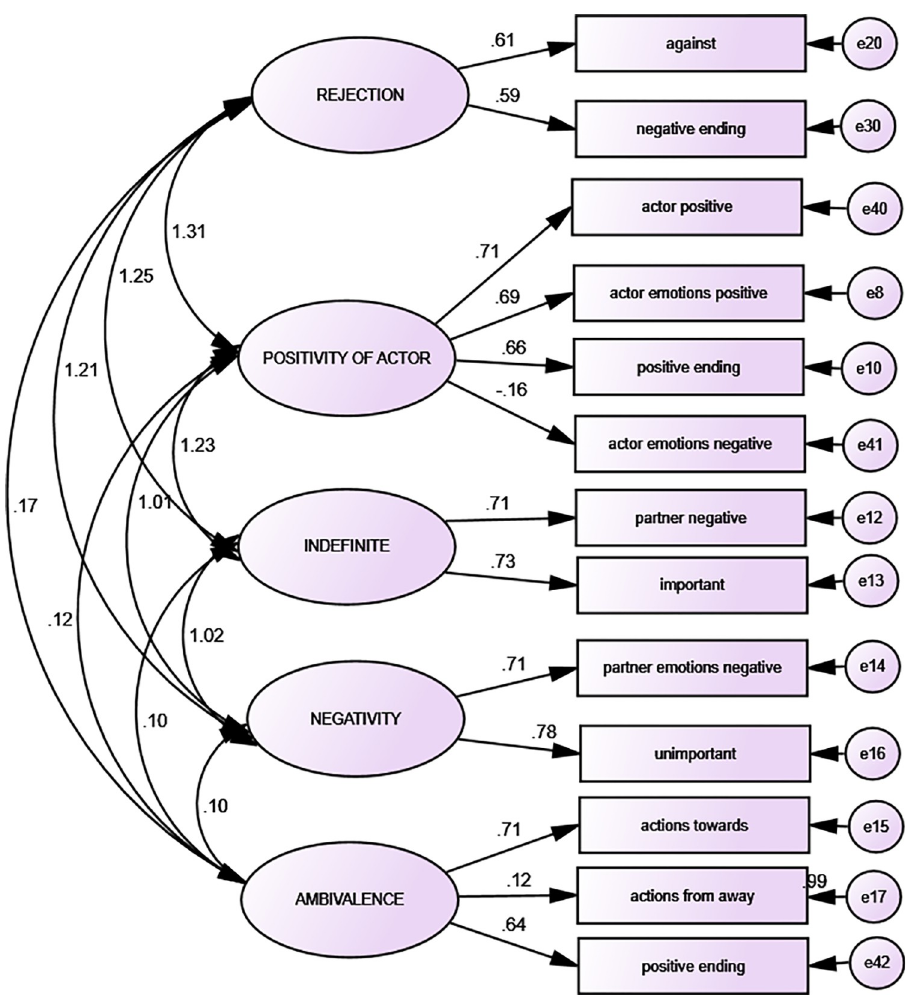
Fig 3. Hate: Confirmatory factor analysis (n =